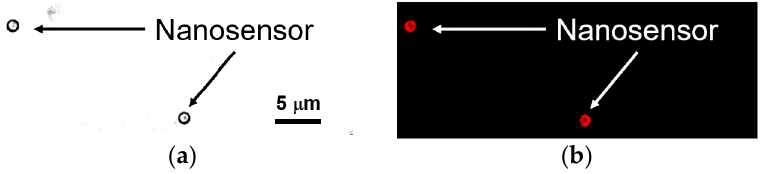
Figure 5. Optical and fluorescence image of the nanosensor. ( a ) Optical image; ( b ) Fluorescence image.